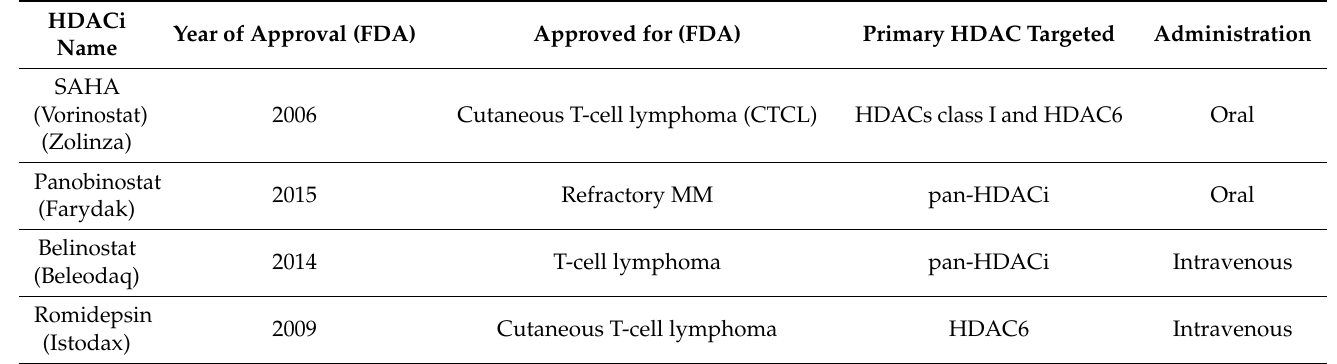
Table 1. List of FDA-approved HDAC inhibitors, with year of approval, treatment and